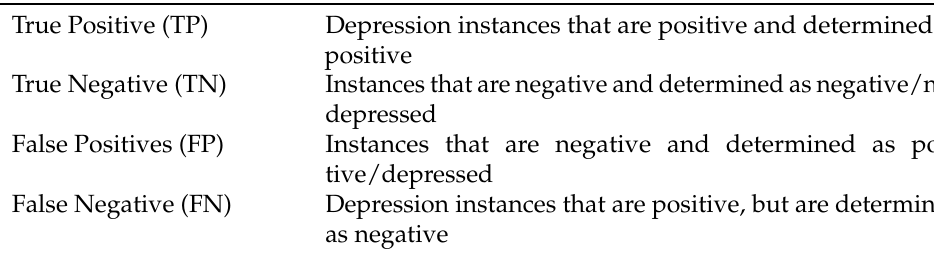
Table 1. Elaboration of TPs, TNs, FPs, and